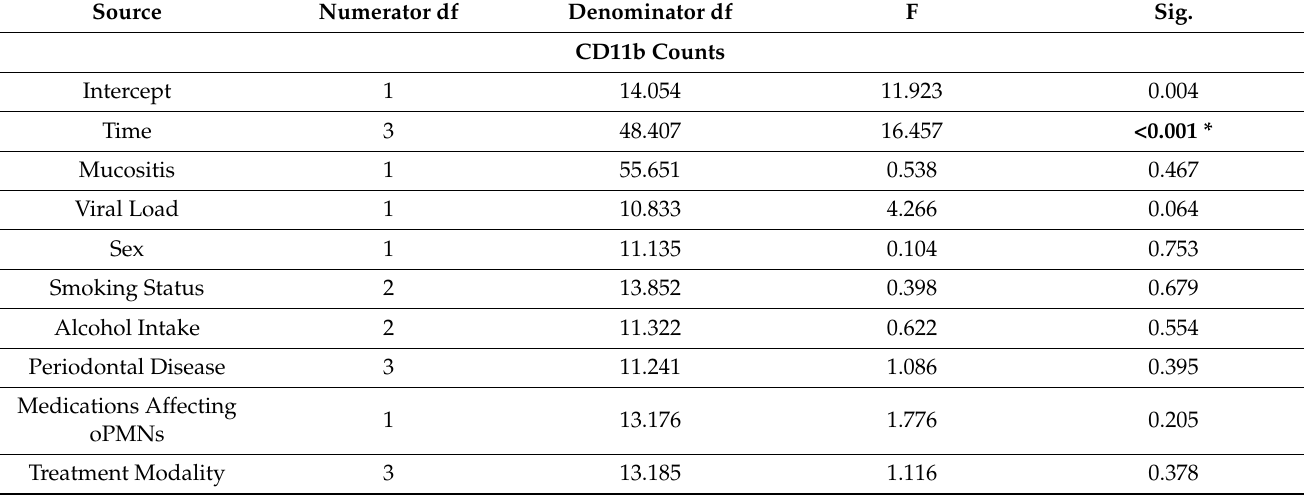
Table A6. Results of the LMM analyses adjusting for covariates for oPMN markers CD11b, CD16, CD18 CD64 and